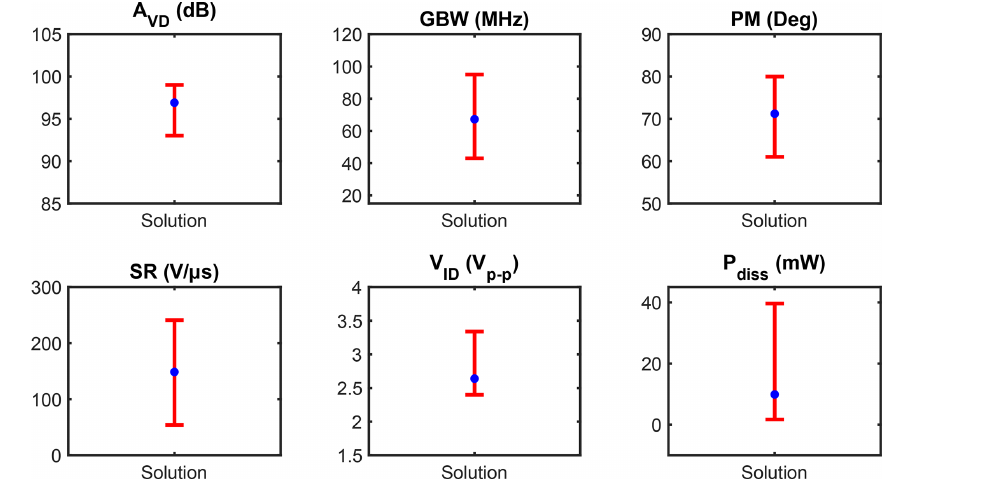
Figure 8. Box plots of the ERPSO algorithm over 10 independent runs on CFIA. Table 5. CFIA performance under worst-case process corners of the AMS 0.35µm technology. Where VDD(typ) =